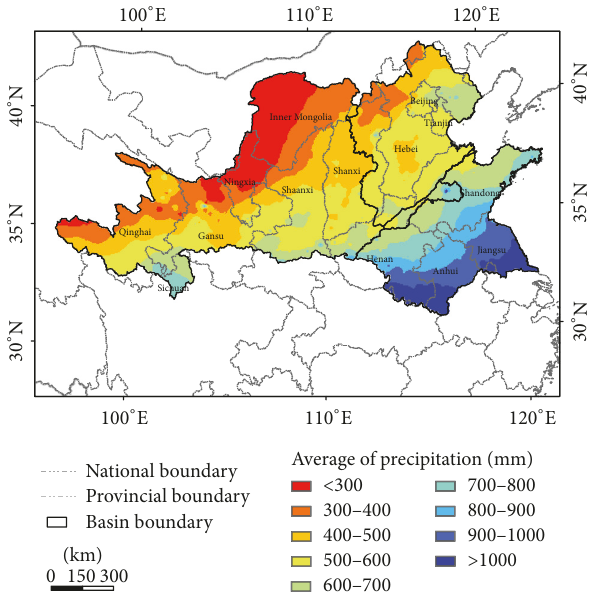
Figure 16: The spatial distribution of multiyear average precipita- tion values from 1961 to 2011.